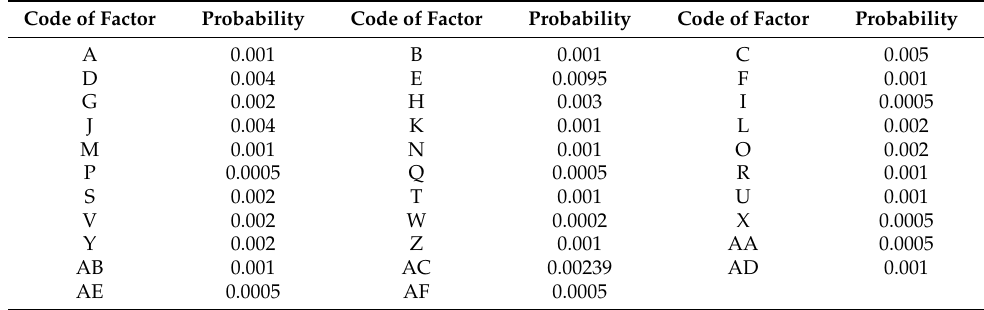
Table 2. The probability of individual basic